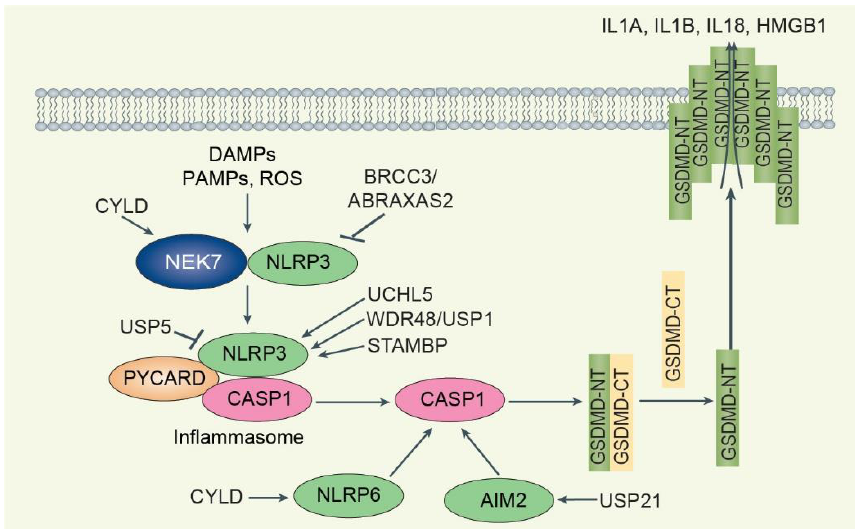
Figure 5. Overview of DUBs-mediated regulation of pyroptosis. DAMPs, PAMPs, and other stim- uli promote inflammasome formation, such as NLRP3-PYCARD-CASP1. NEK7-NLRP3 binding prevents NLRP3 inflammasome formation. CYLD deubiquitinates NEK7 and promotes NEK7-NLRP3 association to inhibit NLRP3 inflammasome formation. While BRCC3/ABRAXAS2 deubiquitinates NLRP3 to promote NLRP3 inflammasome formation, the DUBs UCHL5, WDR48/USP1, and STAMBP promote NLRP3 inflammasome formation. USP5 promotes NLRP3 degradation and attenuates NLRP3 inflammasome activation. CYLD-NLRP6 and USP21-AIM2 regulate the NLRP6-PYCARD and AIM2 inflammasome, respectively. When inflammasome formation is activated, the inflammasome produces mature CASP1, which cleaves intact GSDMD. N-terminal GSDMD (GSDMD-NT) translocates to the inner leaflet of the plasma membrane, causing membrane rupture and release of DAMPs such as IL1A, IL1B, IL18, and HMGB1.